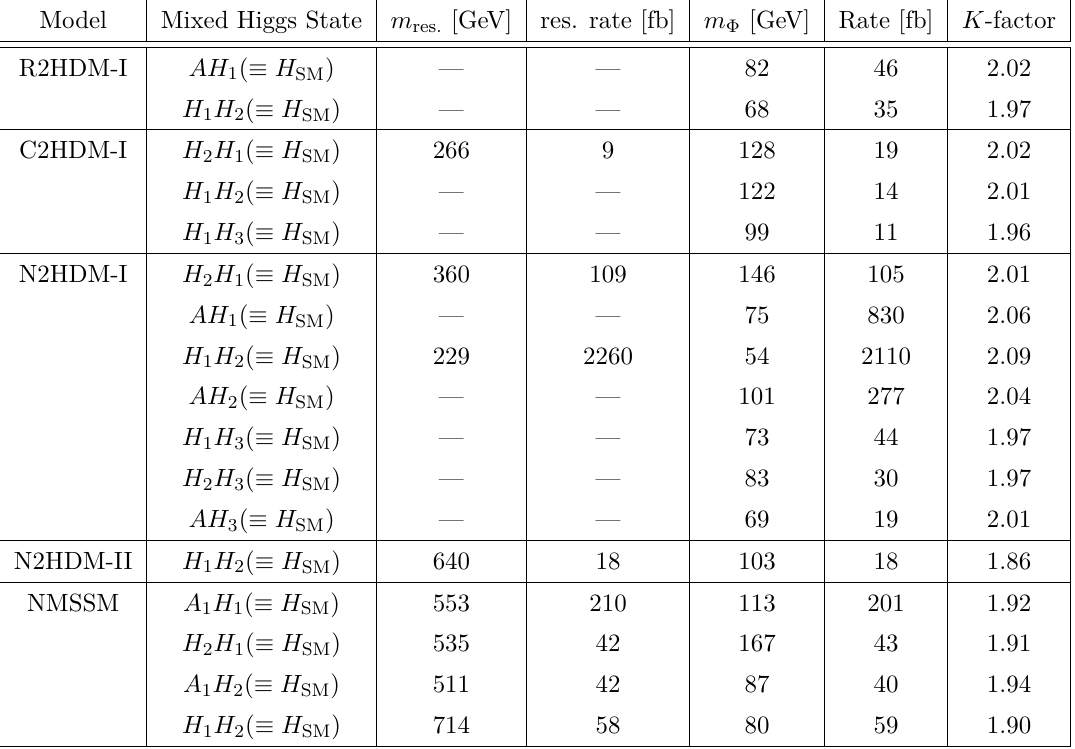
Table 26 . Maximum rates at NLO QCD in the 4 b final state for different mixed Higgs pair final states in the investigated models; the corresponding K -factor is given in the last column. In case of resonantly enhanced production, we give in the third and fourth column, respectively, the mass of the resonant Higgs boson and the resonant cross section as defined in the text. The fifth column contains the mass of the non-SM-like final state Higgs boson. More details on these points can be provided on